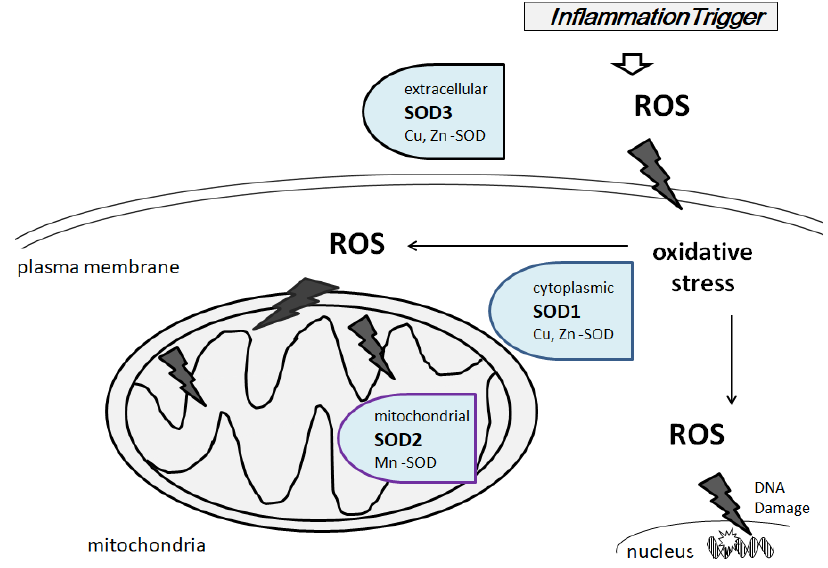
Figure 2. Schematic localization of human SOD1, SOD2, and SOD3 are compartmentalized (SOD1, cytoplasm; SOD2, in the mitochondria; SOD3, in the extracellular space). The lightning bolts show the oxidative attack of ROS on macromolecules such as proteins, lipids, and DNAs.